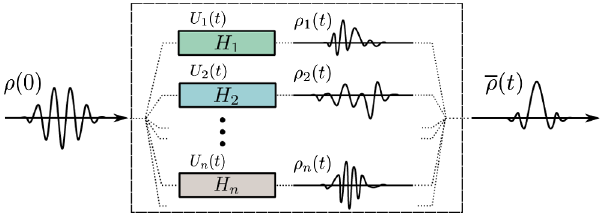
FIG. 1. Effective dynamics of a disordered quantum